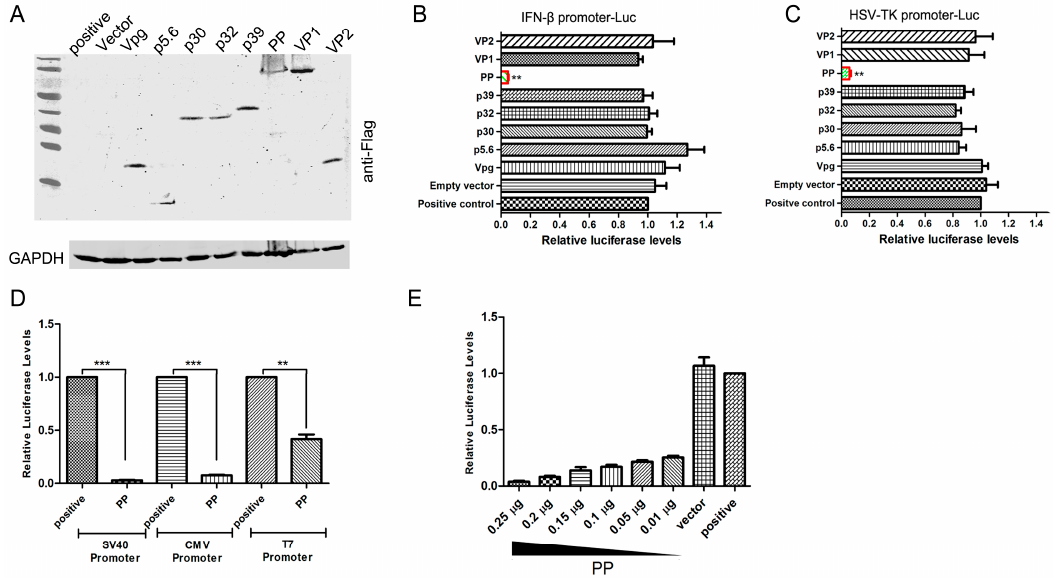
Figure 1. Cont. Figure 1.